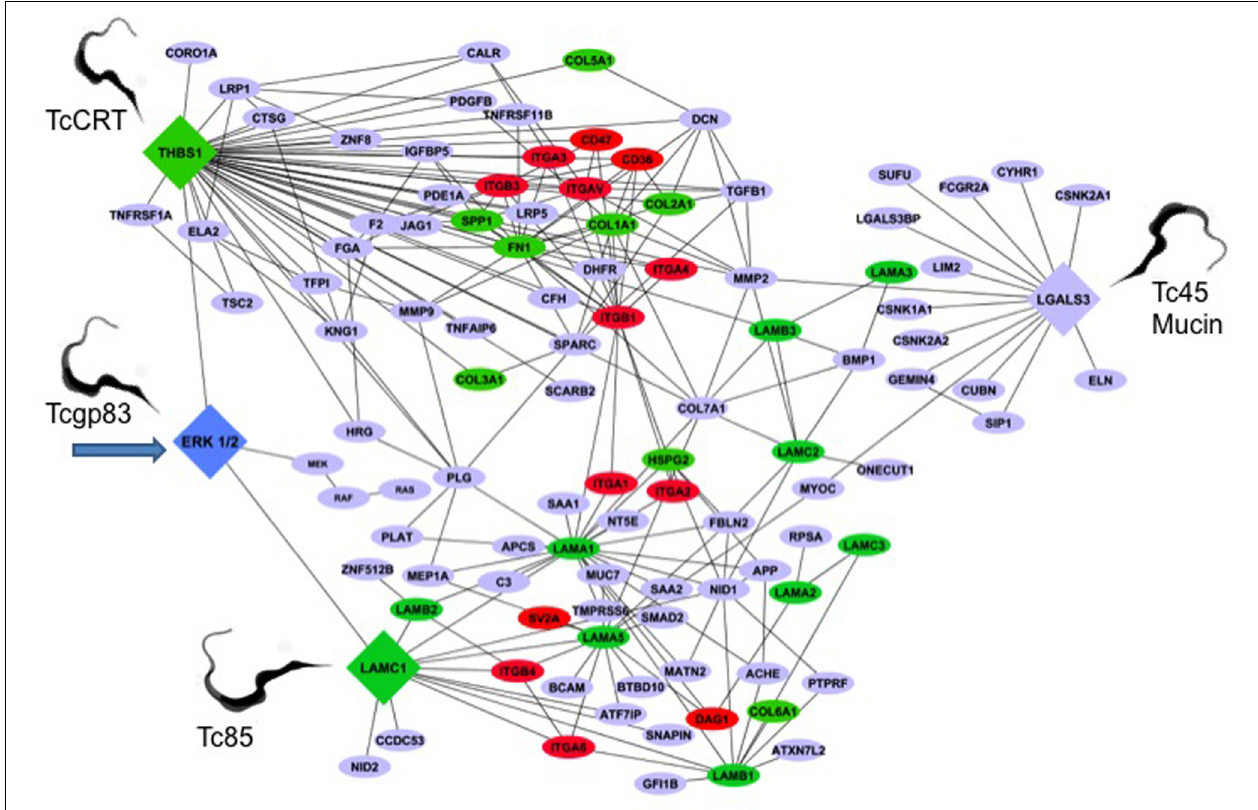
the Michigan Molecular Interaction Database. Proteins mapping to the canonical “ECM-Receptor Interaction Pathway” of KEGG (hsa04512) are highlighted as following: GREEN nodes are ECM ligands (laminins, collagens, fibronectin, heparan sulfate, and thrombospondin-1). RED nodes are ECM receptors: (integrins, cd35, cd47, and SV2A). BLUE nodes are not part of the KEGG ECM–ECM Receptor Pathway, but have established biological interactions with ECM–Receptor interaction nodes. The global interactome was visualized in Cytoscape (version 2.6.3), yielding the ECM interactome involved in early T. cruzi infection.Trypomastigotes pointed in the figure are culture trypomastigotes released from infected cells expressing surfaceTcgp83,TcCRT, andTc45 mucin. All of these trypomastigote surface molecules are also expressed in blood